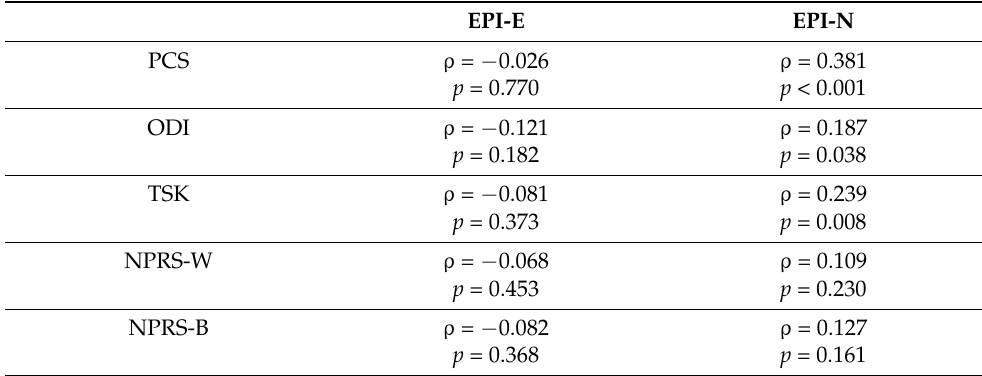
Figure 2. EPI profile. Note: This coordinate system represents the cross section of participants’ EPI-N and EPI-E scores. Each quadrant above corresponds to one of the four profiles identified by the EPI (refer to Figure 1): quadrant I is high neurotic/high extrovert (Choleric), quadrant II is low neurotic/high extrovert (Sanguine), quadrant III is low neurotic/low extravert (Phlegmatic), and quadrant IV is high neurotic/low extrovert (Melancholic). Table 2. Results of the Spearman’s rank correlation analysis between personality, clinical factors, and pain-related psychological factors.